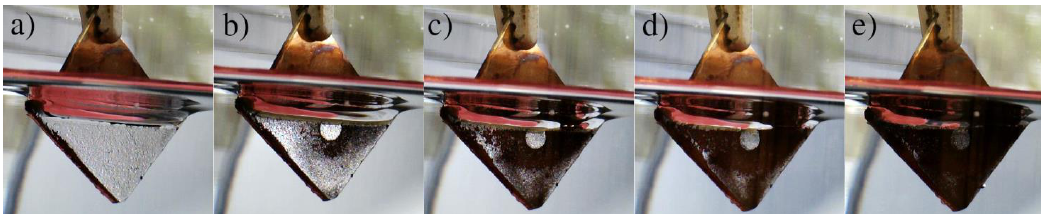
Figure 7. A superhydrophobic sample coated with a Cu–MoS 2 composite coating (Sample A from Table 4) immersed in water for ( a ) 0 s, ( b ) 10 min, ( c ) 20 min, ( d ) 30 min and ( e ) 40 min. A defect